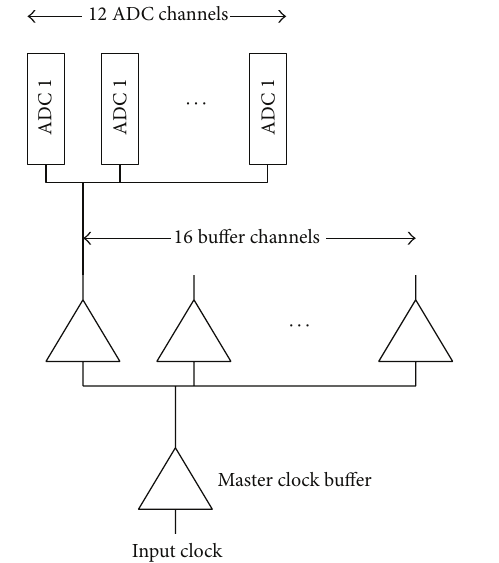
Figure 10: Clock distribution.